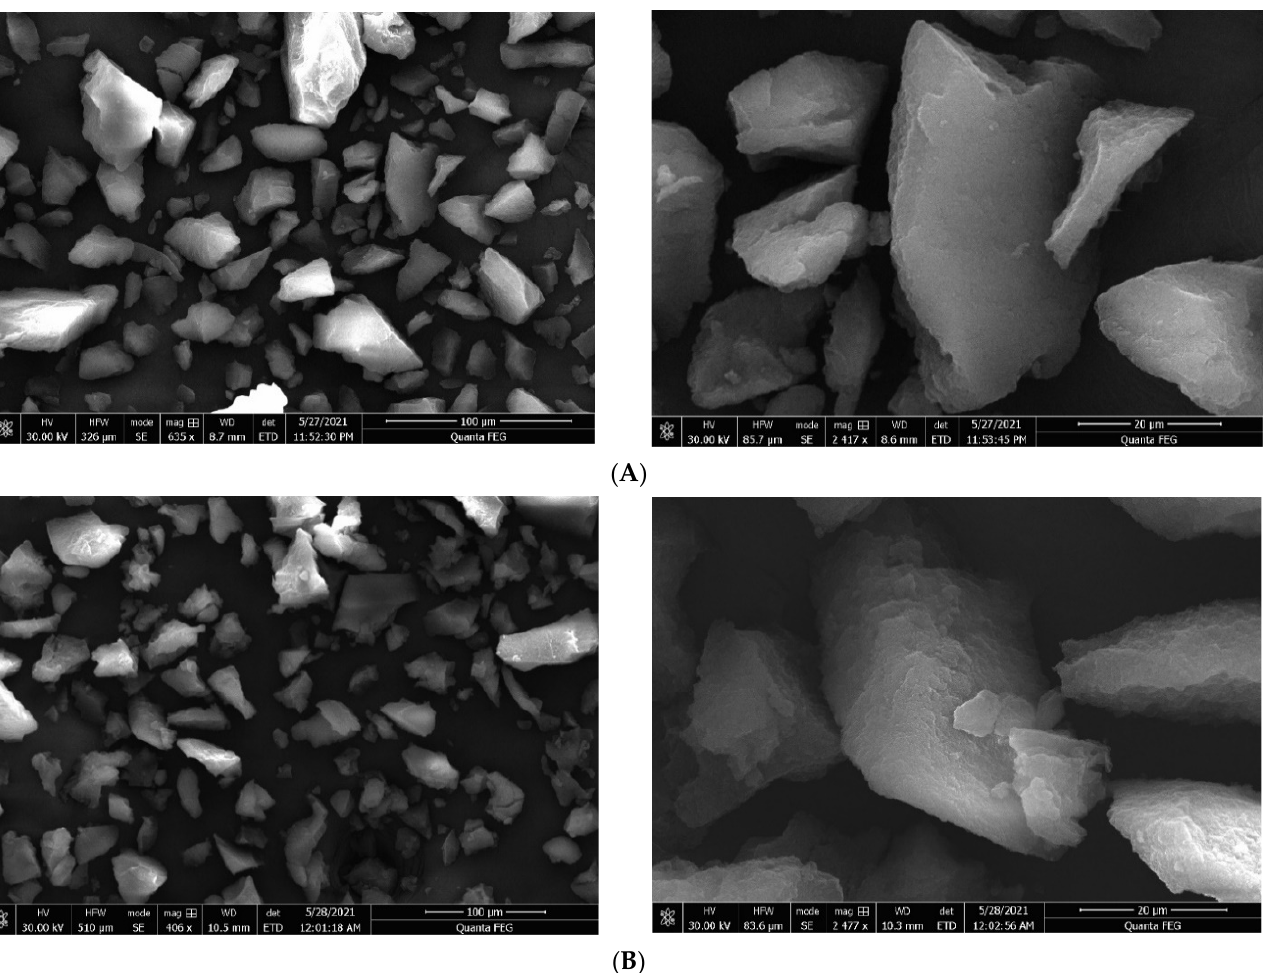
Figure 3. SEM images of ( A ) MIP C and ( B ) NIP C with increasing magnification from left to right.